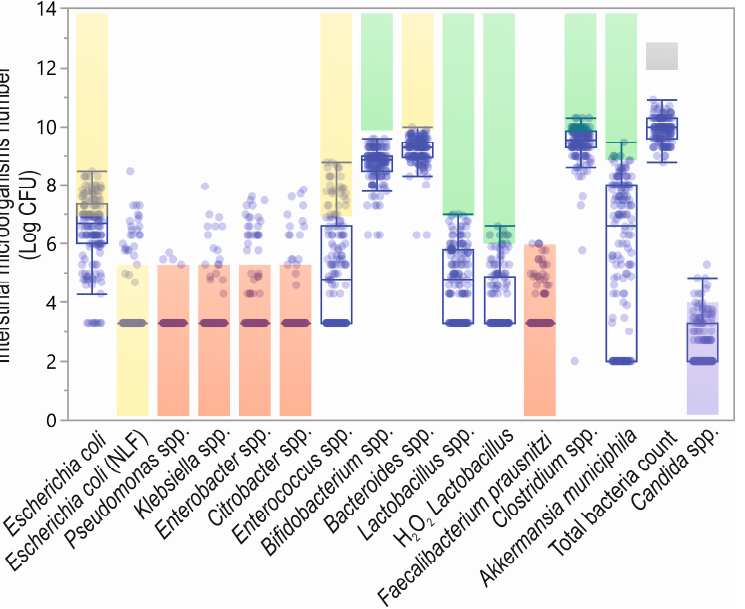
Figure 5. Microbiota species in analyzed patients with reference values. The shadow boxes represent the reference values (according to the Institute of Microecology (Herborn, Germany): green—protective species; yellow—immunostimulating species; red—potentially pathogenic species; grey—total bacteria count; violet—candida spp.); Log CFU—logarithmic transformed colony-forming units.